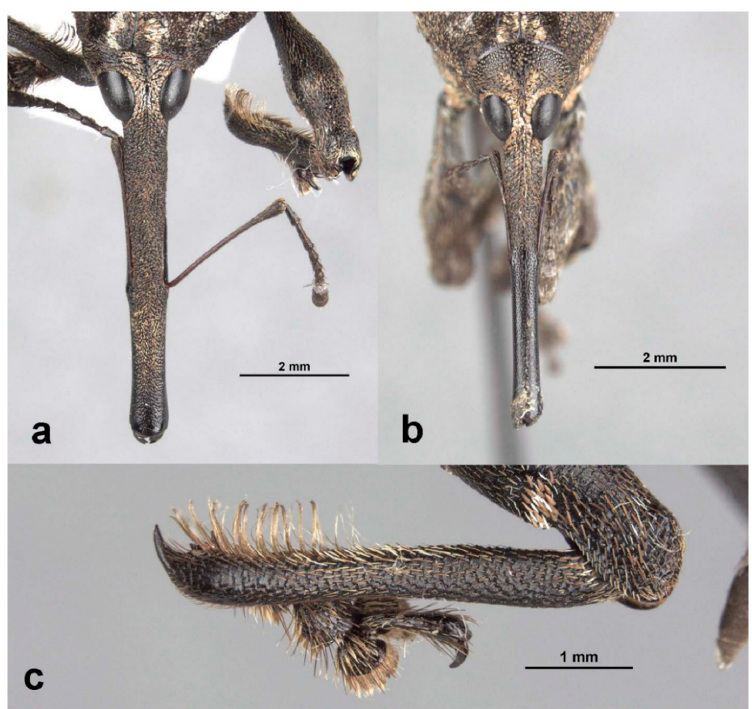
Figure 7. Ilacuris laticollis : ( a ) rostrum of male, dorsal aspect; ( b ) rostrum of female, dorsal aspect; ( c ) protibia of male, anterior aspect.